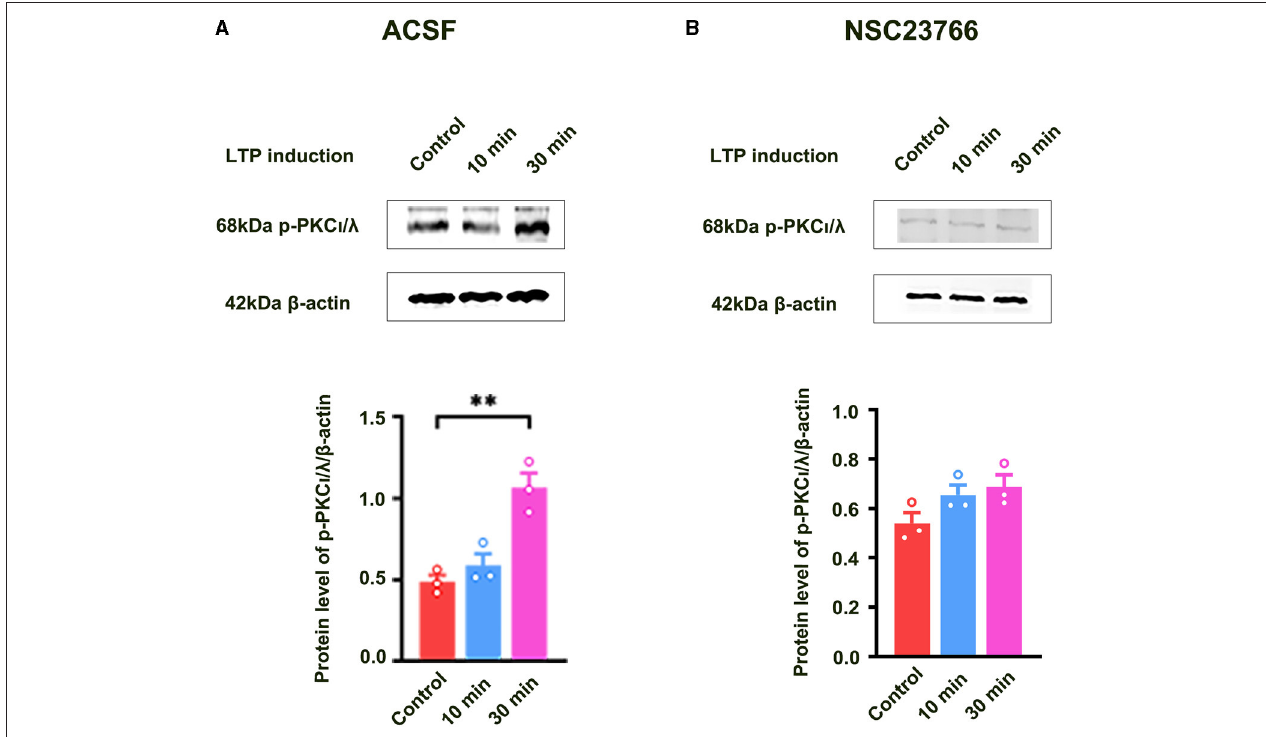
FIGURE 3 | Influence of Rac1 inhibitor NSC23766 on HFS-induced activation of PKC ι / λ . (A) Influence of three trains of HFS on PKC ι / λ activation (one-way ANOVA, ** P < 0.01, n = 3 in each group). (B) Influence of Rac1 antagonist NSC23766 (100 µ M) on PKC ι / λ activation after giving HFS (one-way ANOVA, P > 0.05, n = 3 in each group). All data are shown as mean ±